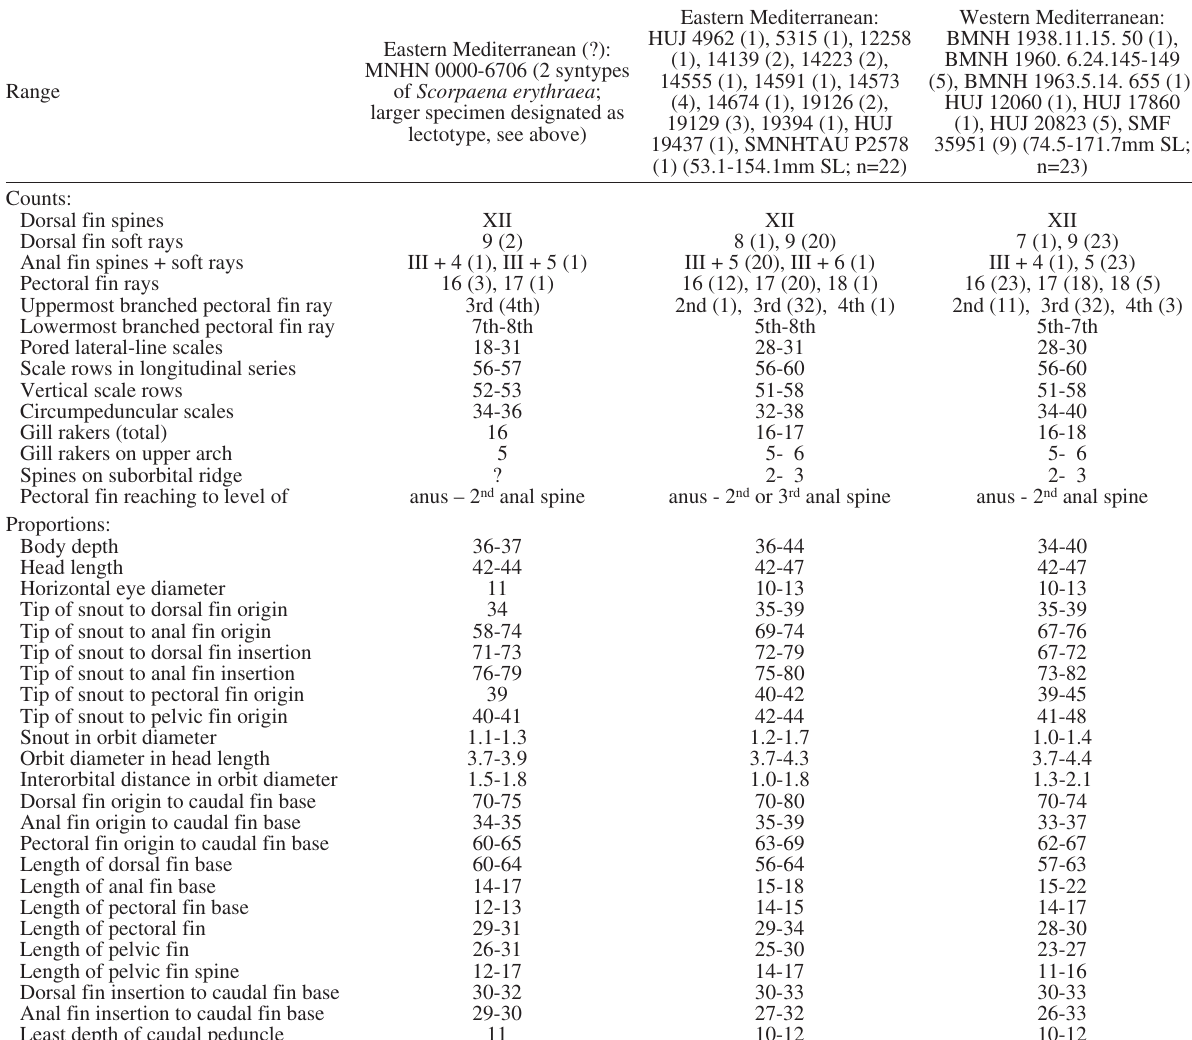
Table 3. – Selected counts and body proportions of Mediterranean specimens of Scorpaena porcus Linnaeus, 1758; proportions expressed as percentage of standard length unless otherwise stated. Number of specimens in parentheses.